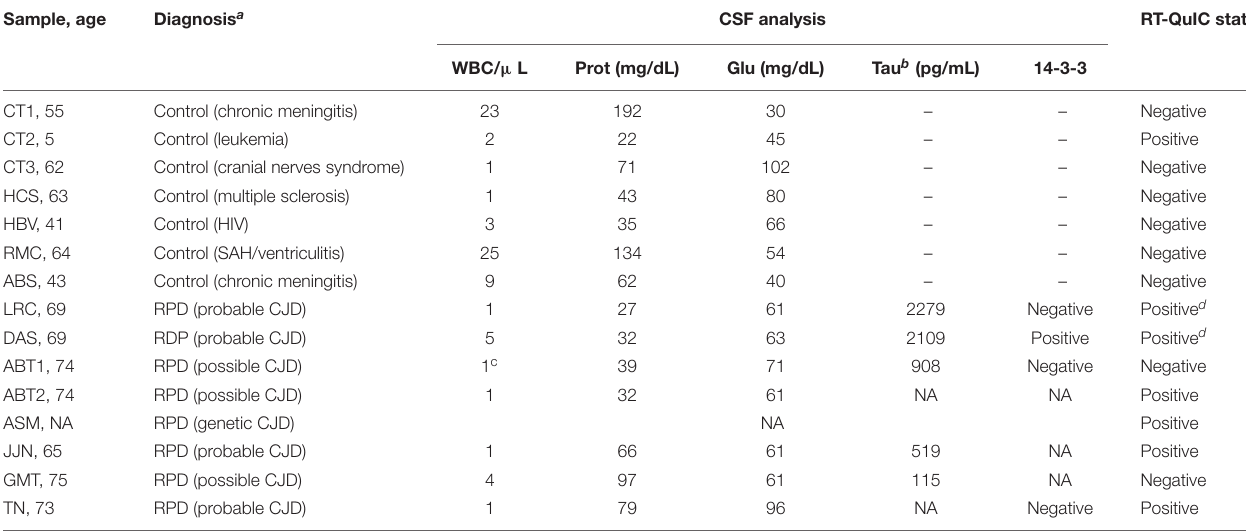
TABLE 1 | Results of diagnostic investigations in the tested patient cohort. Sample,